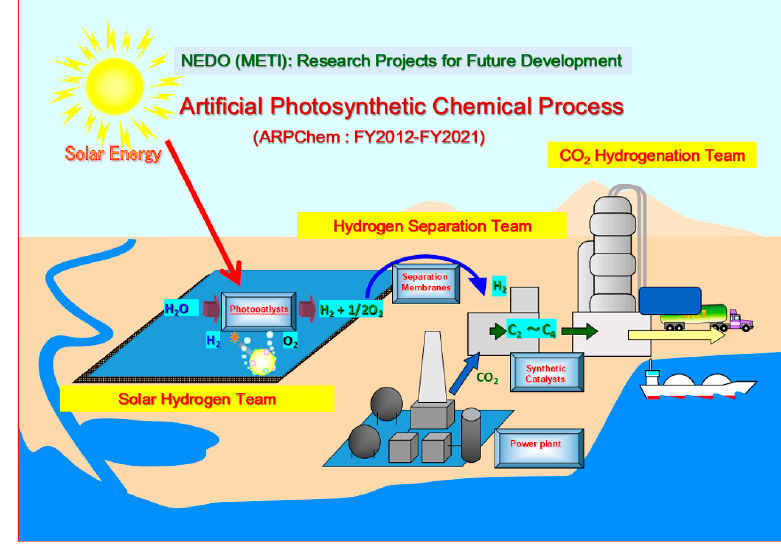
Figure 1. Schematic diagram of ARPChem. ARPChem is a research and development union of leading chemical firms of Japan, funded by New Energy and Industrial Technology Development Organization (NEDO), a subside agency of Ministry of Economy, Trade and Industry (METI) [2]. There are three research teams: Solar Hydrogen Team for water photo-splitting catalysts, Hydrogen Separation Team for gas separation membranes, and Synthetic Catalyst Team for CO 2 hydrogenation catalysts, all concentrating in materials research and development. These teams also have their missions for future planning and designing industrial photocalatlytic plants, gas separation apparatuses, and catalytic synthesis plants, respectively.